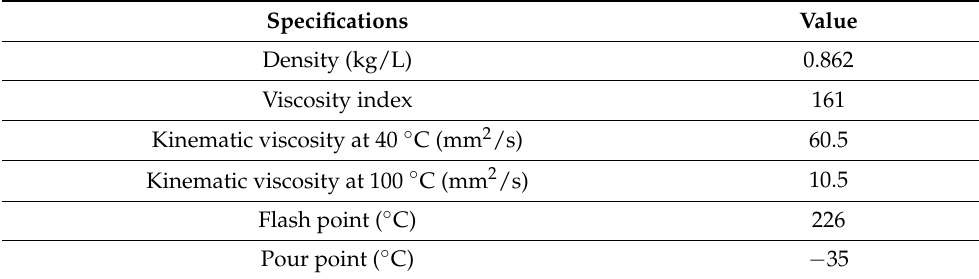
Table 1. Technical properties of lubricant oil 10W30.